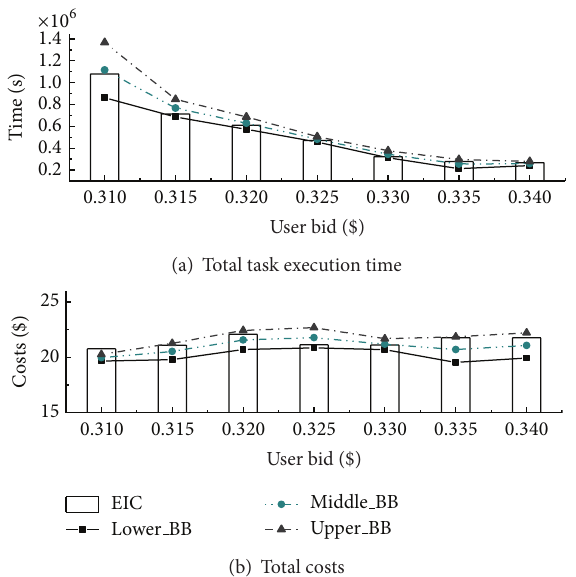
Figure 18: Comparison of actual EIC outputs (execution time and cost) and estimations according to the user bid.